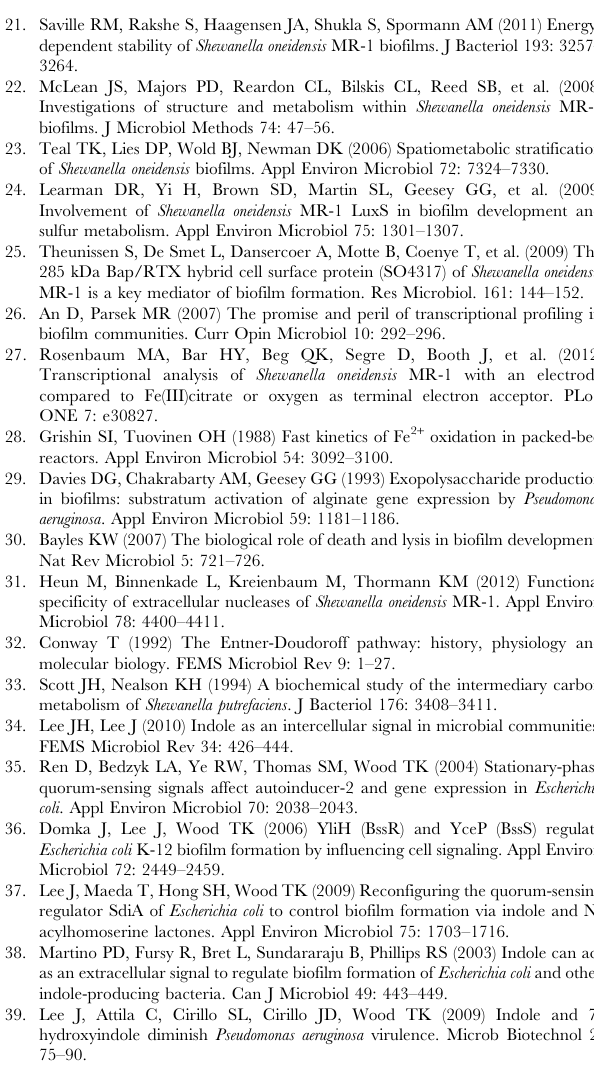
Table S6 Differentially regulated genes related to ‘‘metabolic adaptation’’ - Nucleotide transport and metabolism. Table S7 Differentially regulated genes related to ‘‘metabolic adaptation’’ - Energy metabolism and related. Table S8 Sequence of primers used in this